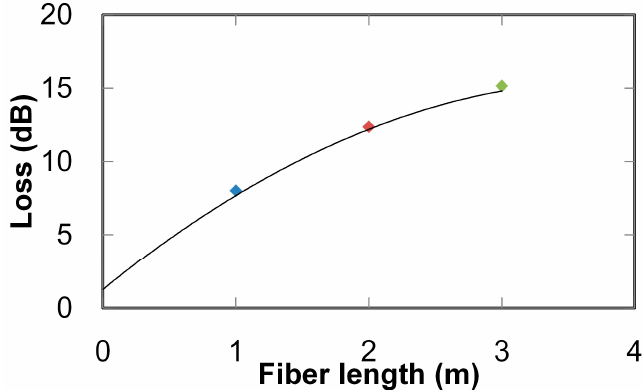
Figure 2. Transmission-loss spectrum of aluminum-coated hollow optical fiber with inner diameter of 1 mm and length of 1 m.